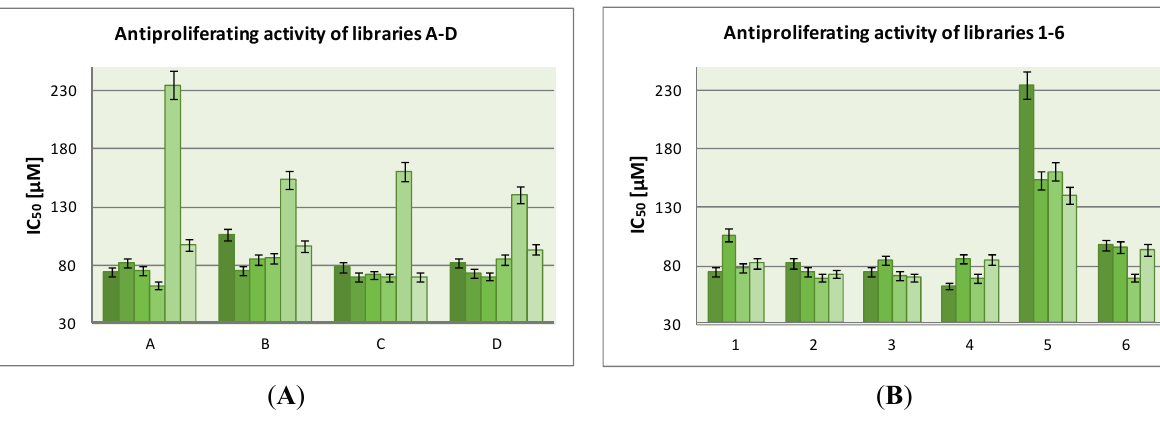
Figure 6. DNA-binding activity of libraries A – D ( A ) and 1 – 6 ( B